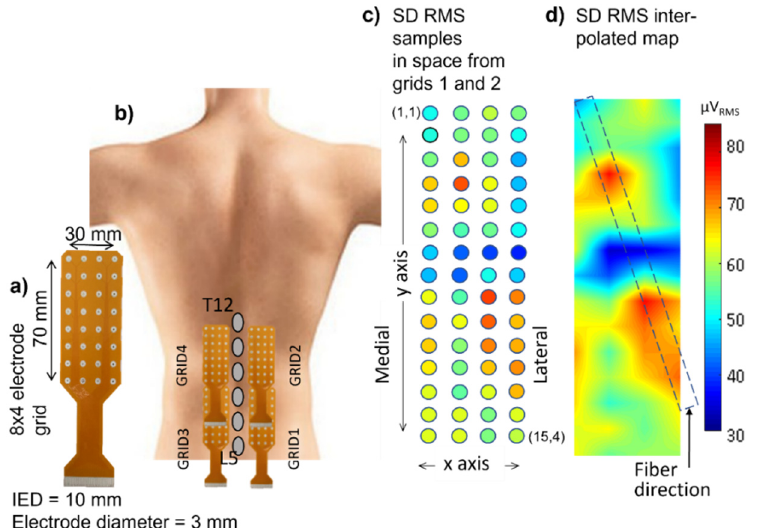
Figure 17. Example of sEMG distribution on the erector spinae of a healthy subject: ( a ) grid of 8 × 4 electrodes (electrode diameter = 3 mm; center-to-center interelectrode distance IED = 10 mm). ( b ) two such grids are applied on each side of the spine to produce an array of 15 × 4 single differential signals whose root mean square (RMS) value (over a 1s epoch) is depicted in ( c ), according to the color scale; ( d ) interpolated image, obtained from ( c ), of the RMS distribution with an indication of the orientation of the fibers. The blue area in the middle corresponds to the innervation zone of the superficial motor units.